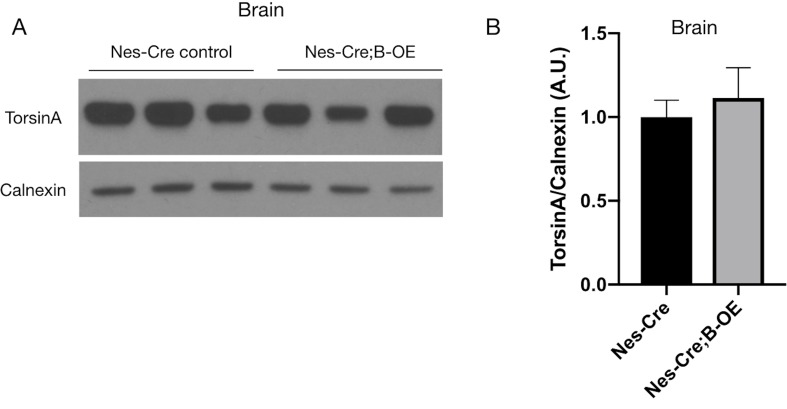
Quantification of torsinB in Nestin-Cre;B-OE liver tissue.(A) Western blot of whole liver lysates from Nestin-Cre and Nestin-Cre;B-OE littermates probed with anti-torsinB antibody. (B) Quantification of western blots of whole brain lysates from Nestin-Cre and Nestin-Cre;B-OE littermates probed with anti-torsinB antibody. The B-OE allele does not alter torsinB overexpression in liver, which is outside of the Cre field (unpaired t-test t4 = 4560, p=0.6720; Nestin-Cre n = 3, Nestin-Cre;B-OE n = 3).Figure 3—figure supplement 1—source data 1.Information pertaining to torsinA expression in torsinB overexpression brain tissue.